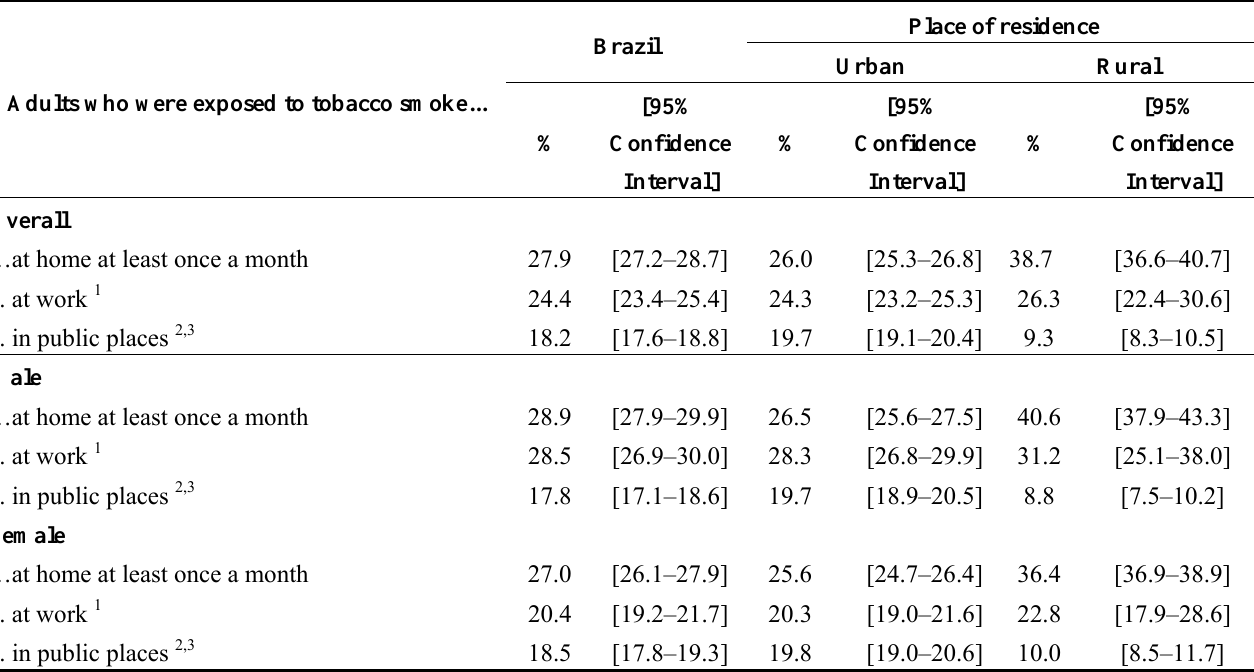
Table 5. Percentage of adults ≥ 15 years old who are exposed to tobacco smoke at work, in health care facilities, in restaurants, in public transportation an in government buildings or offices, by place of residence and gender, GATS Brazil, 2008.